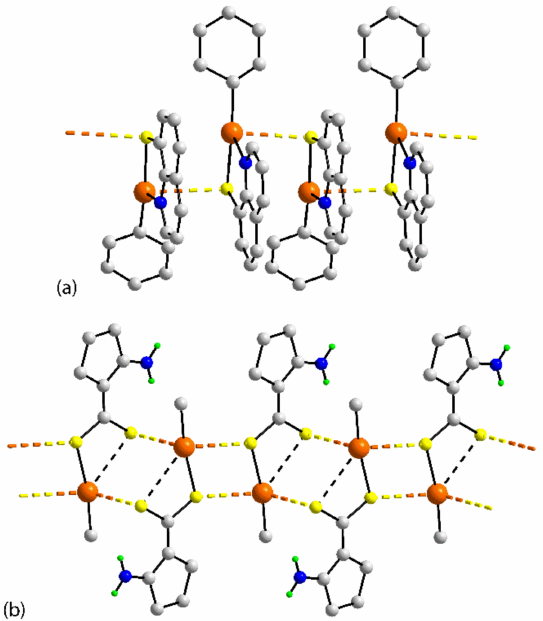
Figure 21. Supramolecular association in the crystals with twisted one-dimensional aggregation encompassing Hg ··· S interactions: ( a ) di-nuclear 56 and ( b ) di-nuclear 57 .